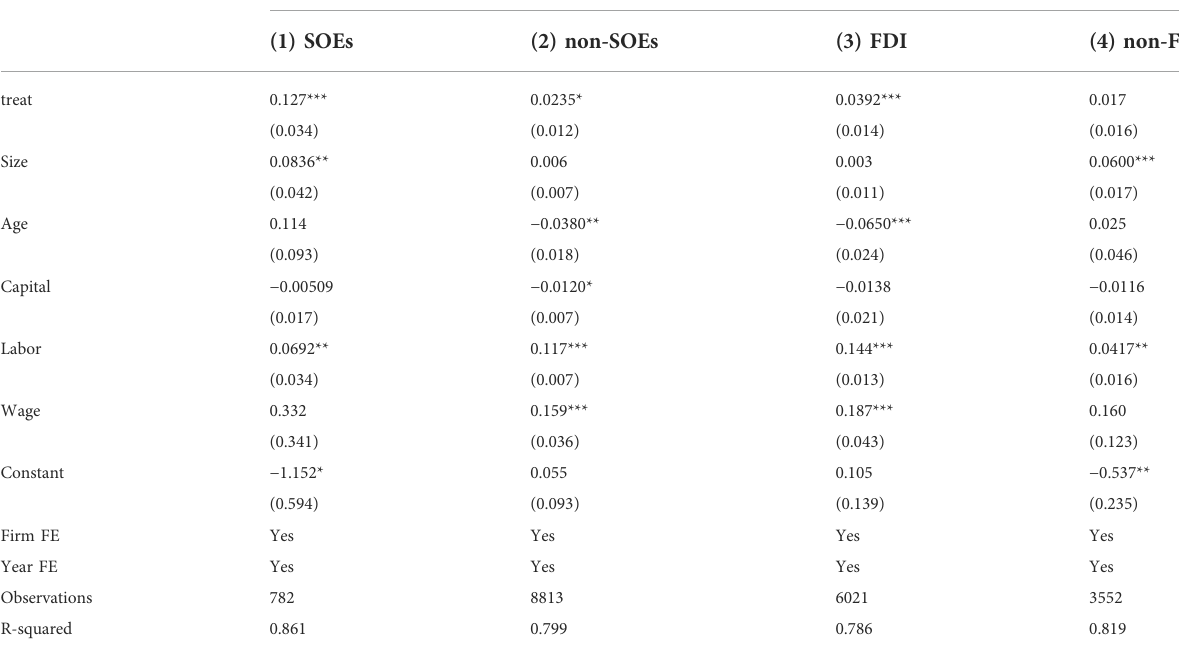
TABLE 5 Heterogeneous results of fi rm ownership.